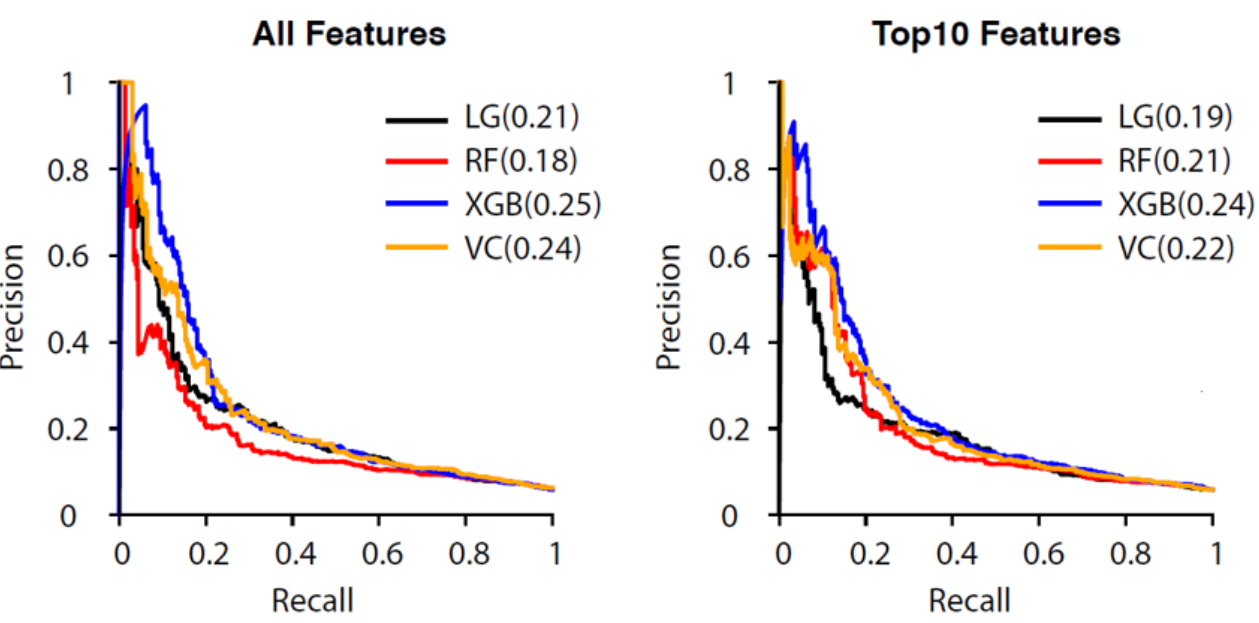
Figure 5. Comparisons of the precision–recall curves (PR curves) of different models in predicting unscheduled revisits to the emergency department within 72 h of discharge: ( left ) prediction made by using all collected features; ( right ) the same prediction made using only the top 10 features from each model (ranked by importance). The area under the PR curve is shown in parentheses.